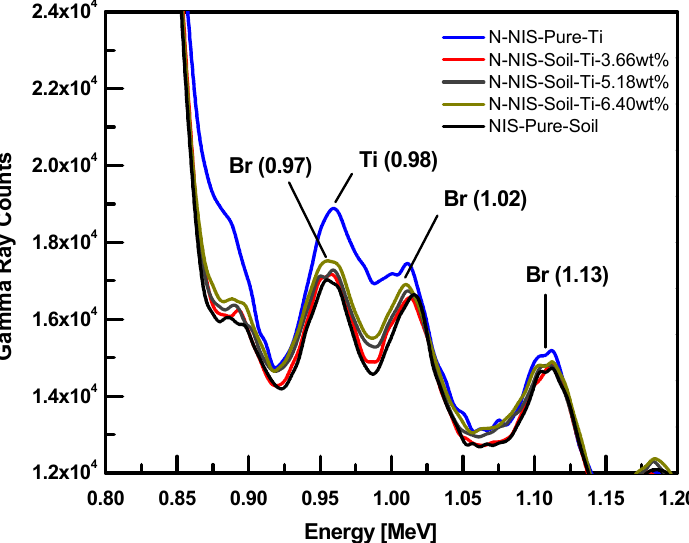
Figure 4. Prompt gamma-ray spectra of three soil samples containing 3.66, 5.18, and 6.40 wt% Ti superimposed upon background spectrum using CeBr 3 detector. The spectrum of a 100 g pure Tir sample overlays the other spectra.